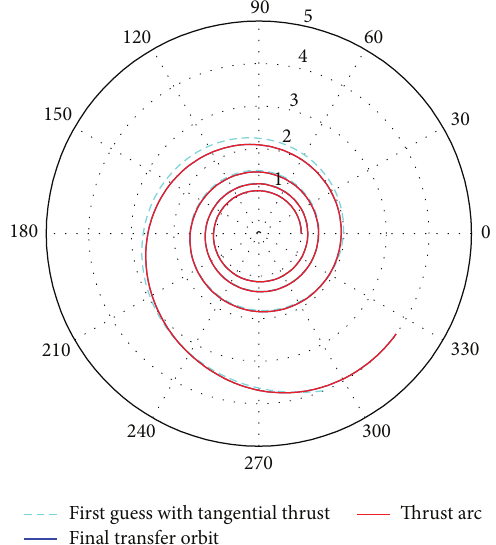
Figure 15: Optimal transfer orbit of fuel-optimal problem.